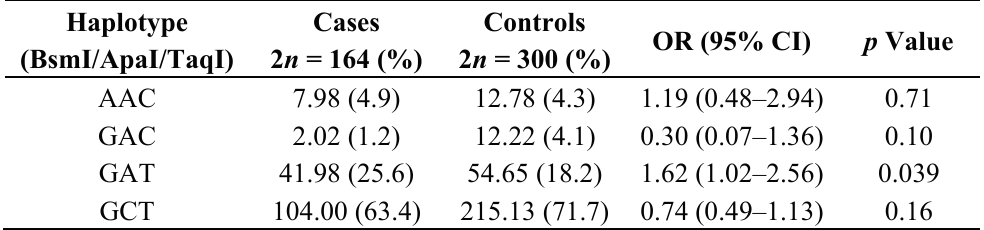
Table 3. Haplotype frequencies for VDR polymorphisms in cases and